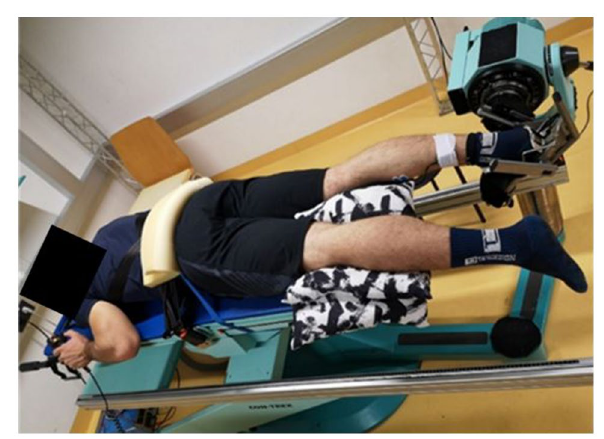
FIGURE 2 | Measurement setup in the laboratory. The participant is positioned prone and fixed on the dynamometer to prevent evasive movements. The pillow underneath the non-testing leg was used to increase subjects’ comfort during the